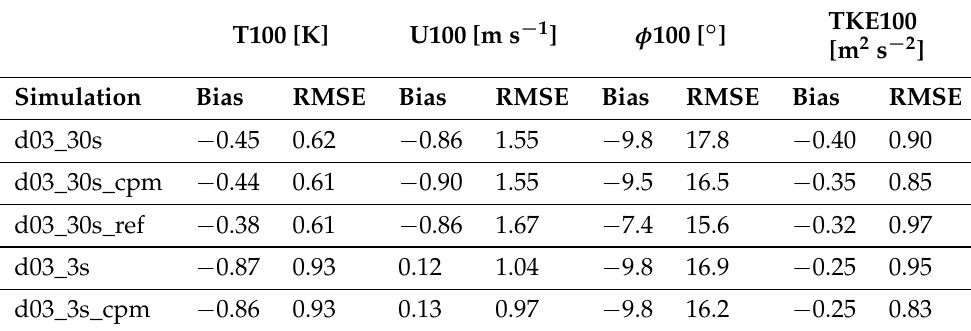
Table 3. As in Table 2 but for data at 100 m above ground